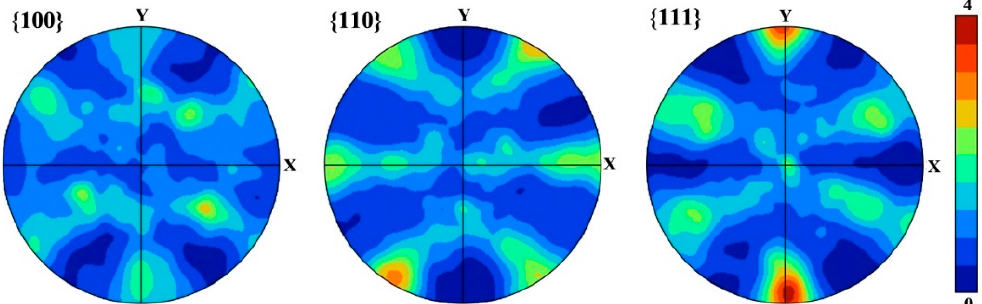
Figure 3. Pole figures for 6 wt.% Mn-doped martensitic steel after solid solution.